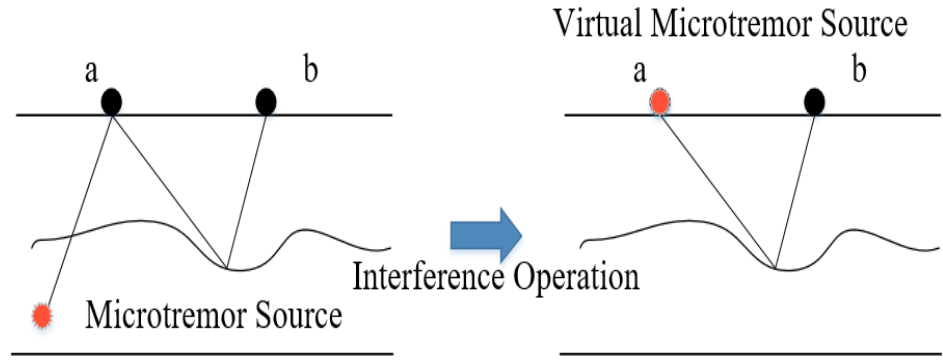
Figure 2. Schematic diagram of SI.